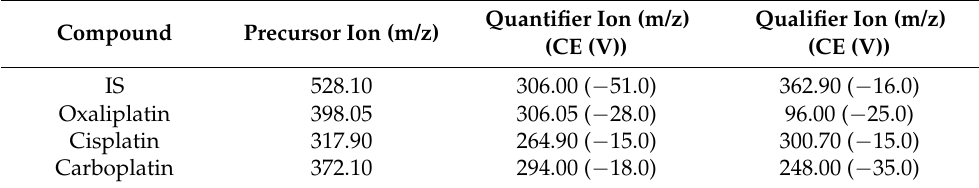
Table 1. Quantifier and qualifier ions for each analyte with the corresponding collision energy utilized under the optimized parameters set in MRM